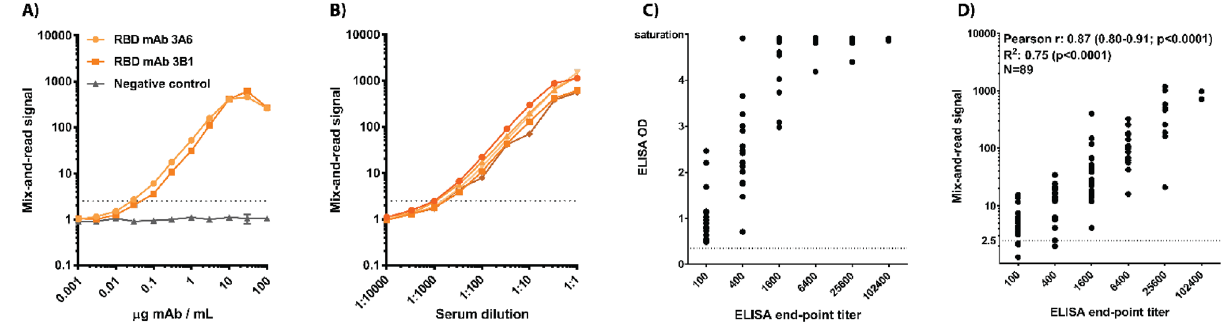
Figure 4. Quantitation. ( A ) Two positive control IgG mAbs and a negative control mAb were titrated to determine the linear range of the mix-and-read signal. ( B ) Five serum samples that gave a strong signal in initial testing (503–1179 fold over background) were titrated in negative human serum to determine if they reached the saturation level identified by mAbs. ( C ) Correlation of ELISA end-point titer and ELISA optical density from 1:100 sample dilution. ( D ) Correlation of ELISA end-point titer and mix-and-read signal. Correlation analysis (Pearson r and 95% confidence interval) and linear regression were performed on log-transformed mix- and-read data and log2-transformed ELISA end-point titers. ( A ) and ( B ): technical duplicates with averages and ranges